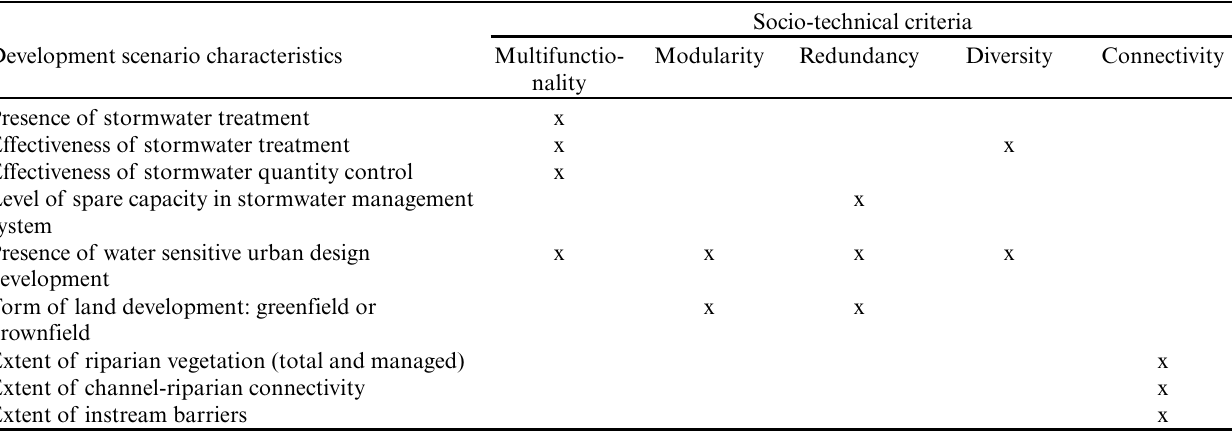
Table 2 . Development scenario characteristics that influence the calculation of scores for each of the five socio-technical capacity criteria (influencing characteristics indicated with